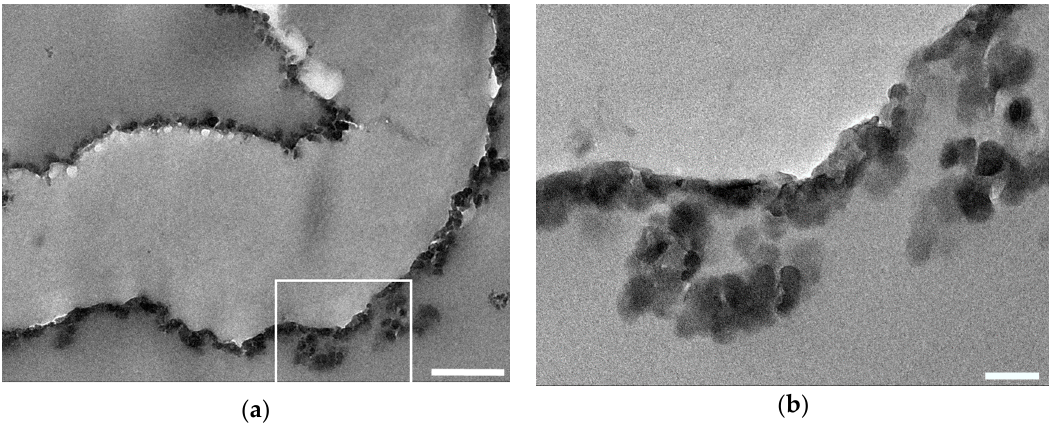
Figure 6. Transmission electron microscopy (TEM) image of a cotton fiber functionalized with UiO-66: ( a ) Cotton fiber cut along its fiber axis. The scale bar corresponds to 500 nm. ( b ) Magnification of the area delimited by the white square in ( a ). The scale bar corresponds to 100 nm.